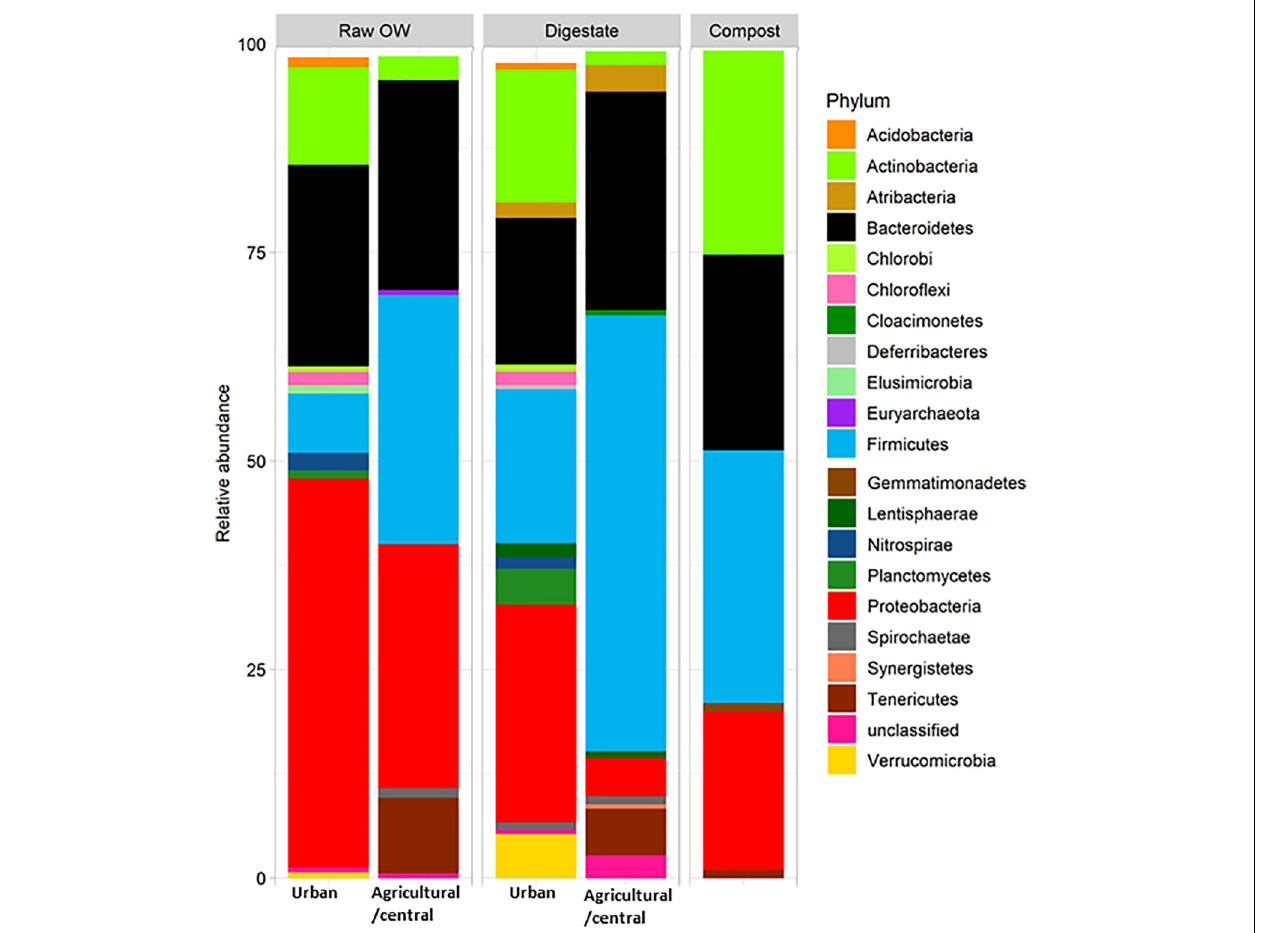
FIGURE 3 | Relative averaged abundances of V5–V6 16S rRNA gene reads allocated to phyla before and after treatment of raw organic wastes (OWs) by anaerobic digestion or composting performed by treatment plants located in rural areas (agricultural/central sites) or urban ones. Only phyla with a relative abundance above 0.5% are displayed (see Supplementary Table 9 for the complete